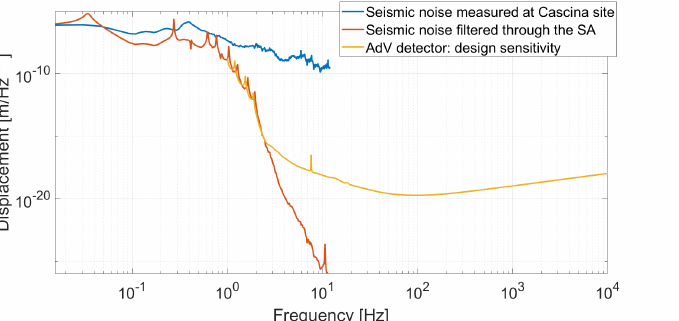
Figure 9. Panel ( a ) shows a technical drawing of the Virgo SA. From top to bottom, the isolation stages are: pre-isolator (inverted pendulum and top filter—F0), five filters and the payload (marionette and mirror). Panel ( b ) shows the SA mechanical transfer function from the ground to the test mass along the longitudinal degree of freedom.